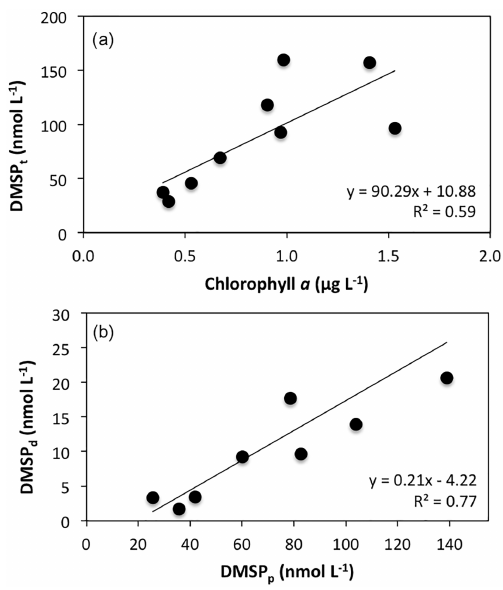
Figure 5. Model II regressions between (a) concentrations of Chl a and DMSP t ; (b) concentrations of DMSP p and DMSP d